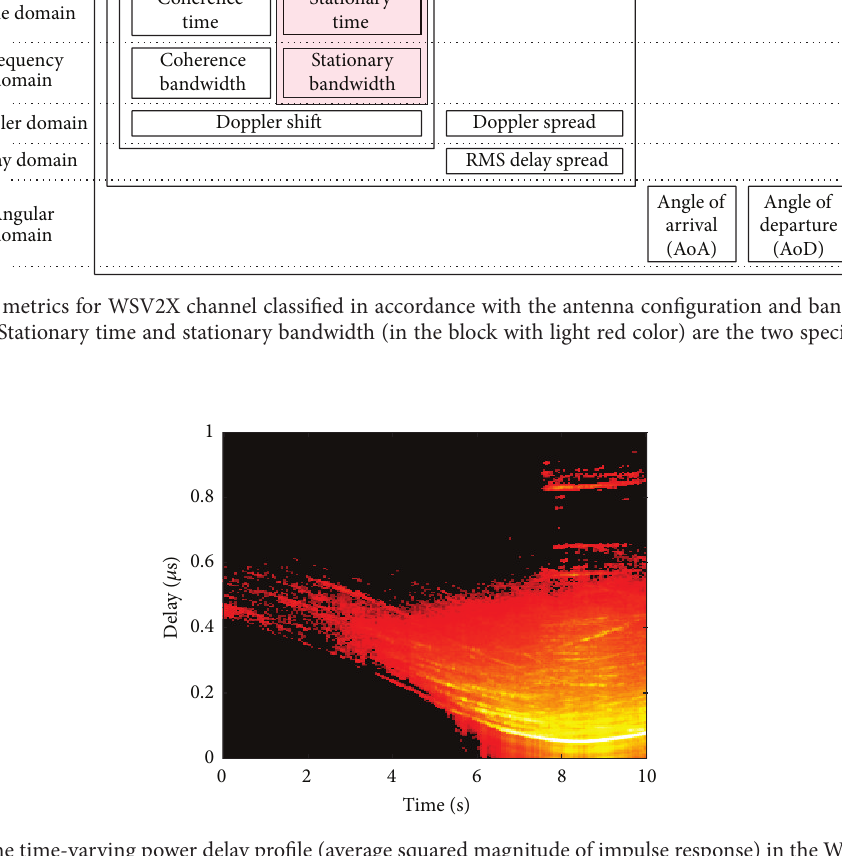
Figure 4: Example of the time-varying power delay profile (average squared magnitude of impulse response) in the WSV2X channel. It can be found that the delay of the first taps varies because the Tx and Rx approach each other firstly and move away from each other later. The LOS tap experiences fading, the gap in the delay domain between strong components (clusters), and the LOS tap changes with time, and there is splitting of clusters over time as